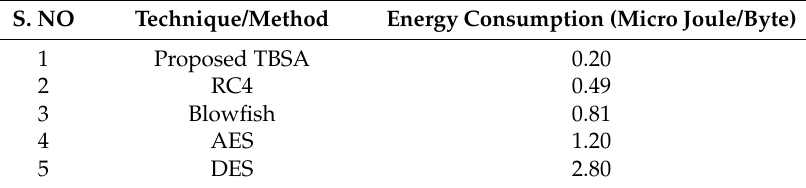
Table 2. Energy consumption comparison with symmetric cipher.